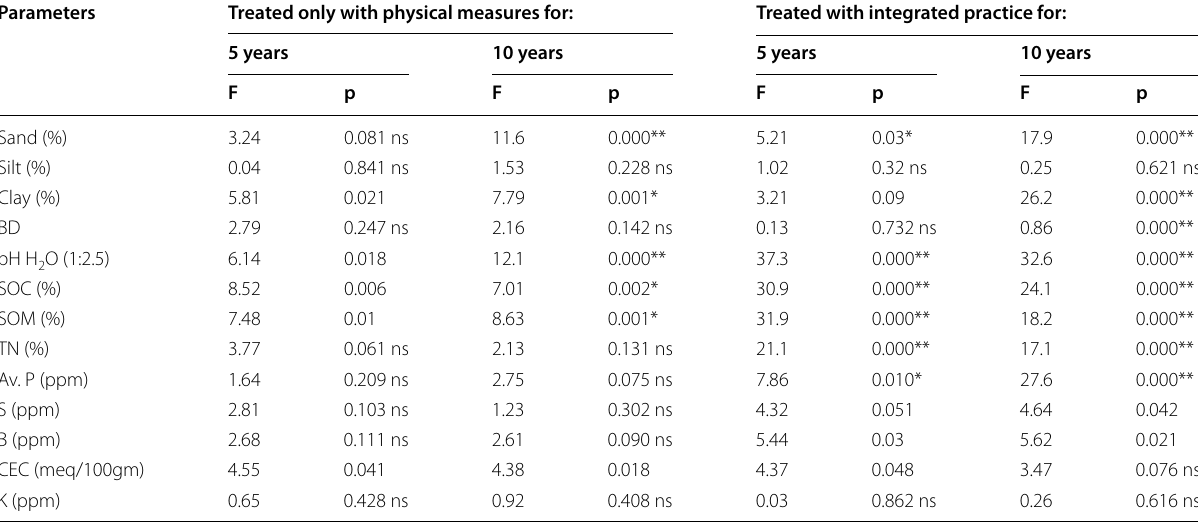
ns non-significant, ALM agricultural land management * Significant at p 0.05 ≤ ** Significant at p ≤